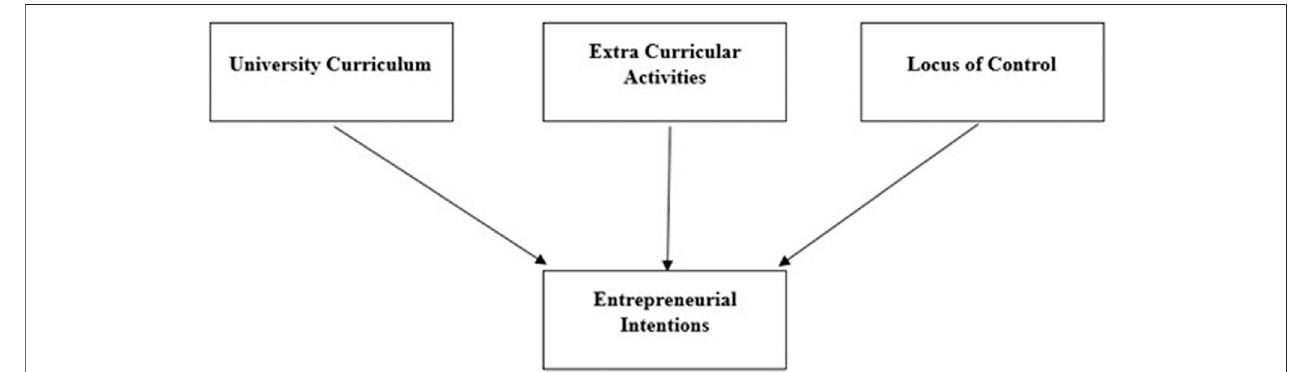
FIGURE 1 | Theoretical model.